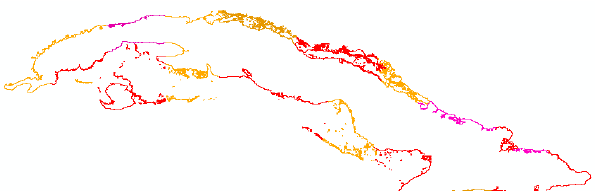
Figure 10. Results of the vectorization of the Cuban archipelago during the dry season